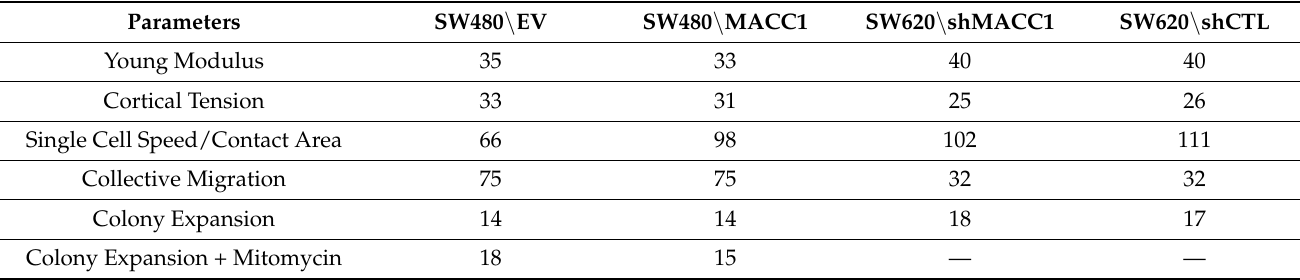
Table A1. Sample